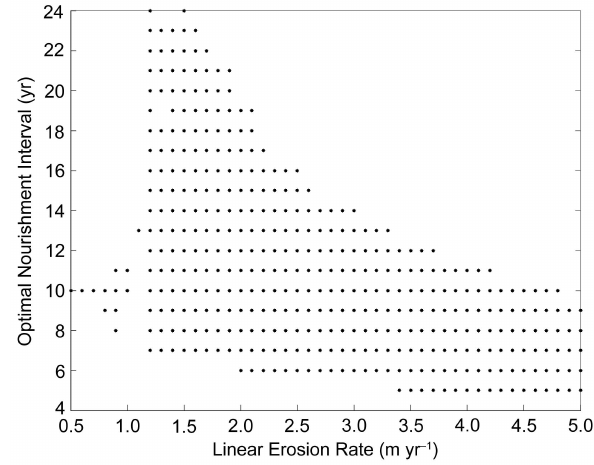
Fig. 6. Bifurcation-type plot summarizing nourishment-interval choices ( τ ) by 100 model towns over 1000 time steps for a range of linear erosion rates ( γ r ) . A critical transition from single-state to a “chaotic” pattern of multiple states occurs at γ r = 1.2myr − 1